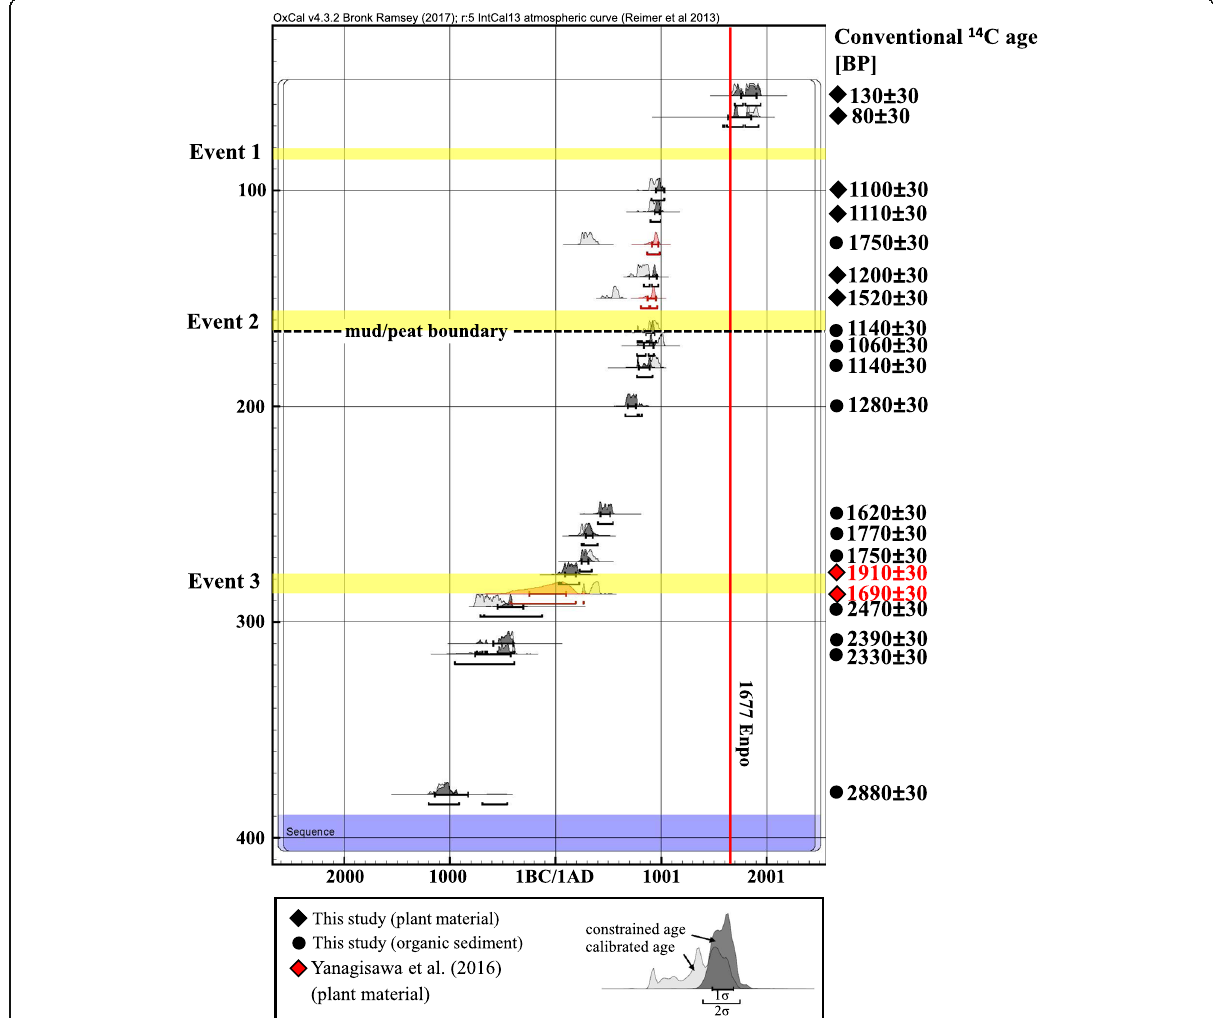
Fig. 6 Calibrated 14 C ages for a probability density distribution. The respective dating results ’ probability densities are shown in light gray; the black ones show probability density distributions constrained using the sequence model. Dating results shown as a red probability density distribution are not consistent with the stratigraphic order, according to the general outlier model in the OxCal program (Bronk Ramsey 2009b); it was thus eliminated from estimation of the age ranges of the event deposits. Marks (red diamond, black diamond, and dot) show sampling points; red, results reported by Yanagisawa et al. (2016); black, samples measured for this study; diamond, plant materials; circle, organic sediments. The vertical red line represents the AD 1677